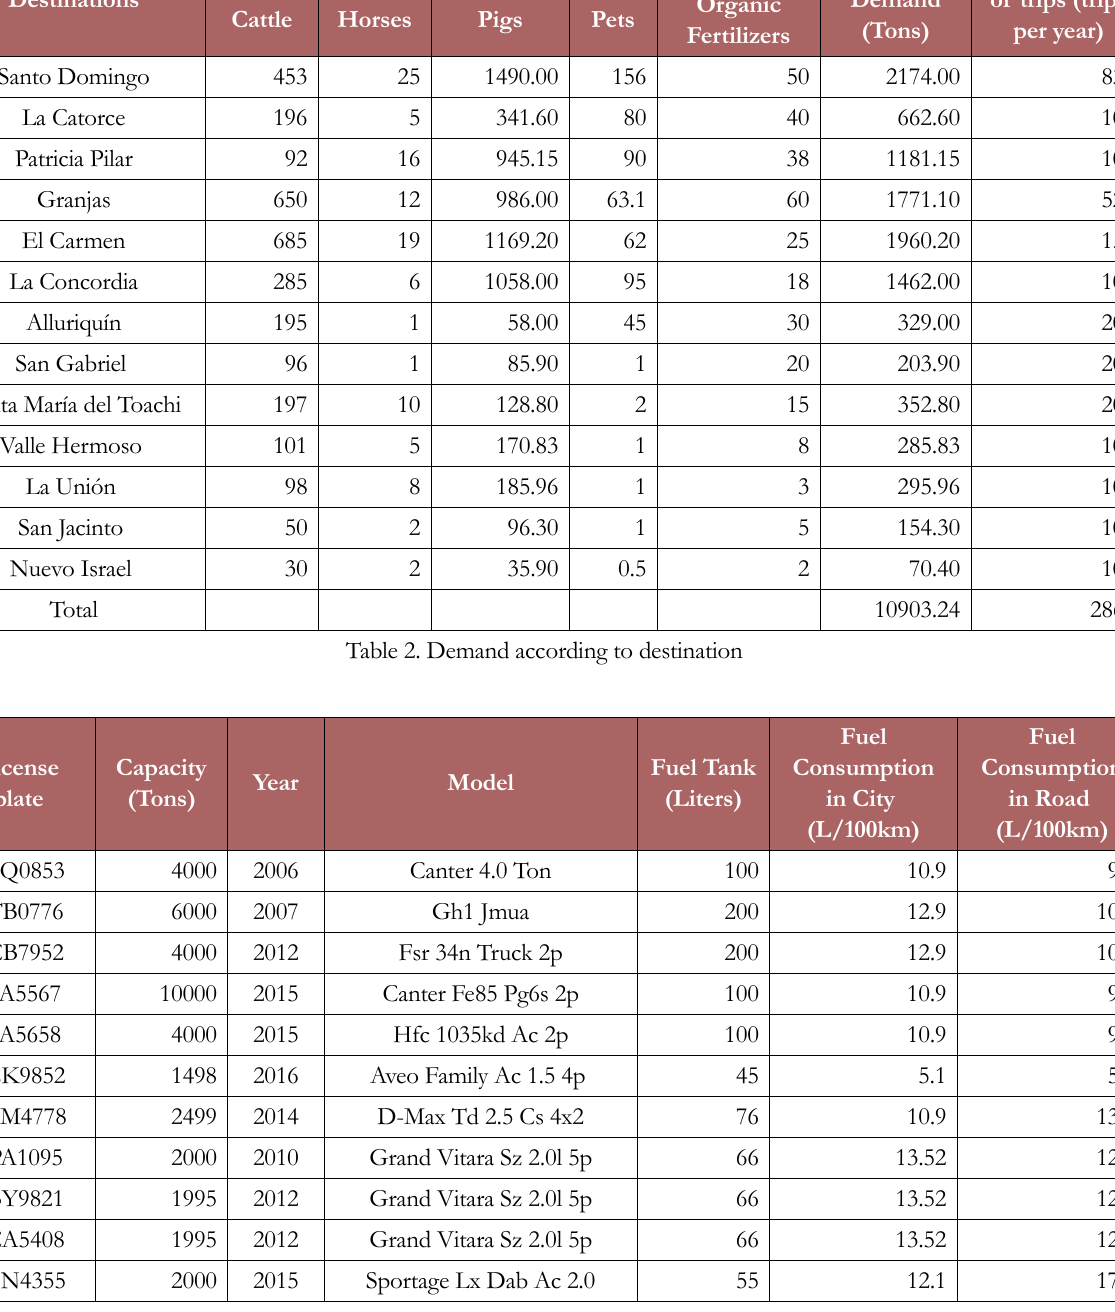
Table 3. Distribution